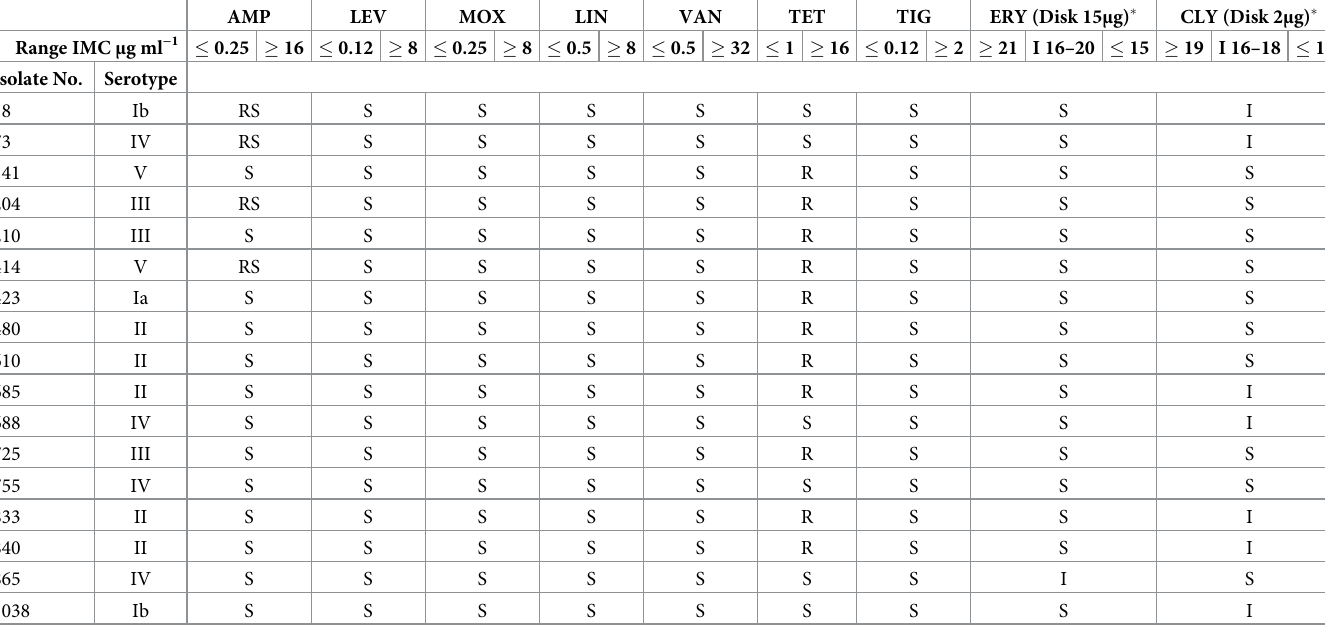
Table 3. Level of antibiotic resistance and serotype of 17 group B Streptococcus (GBS) isolated from pregnant